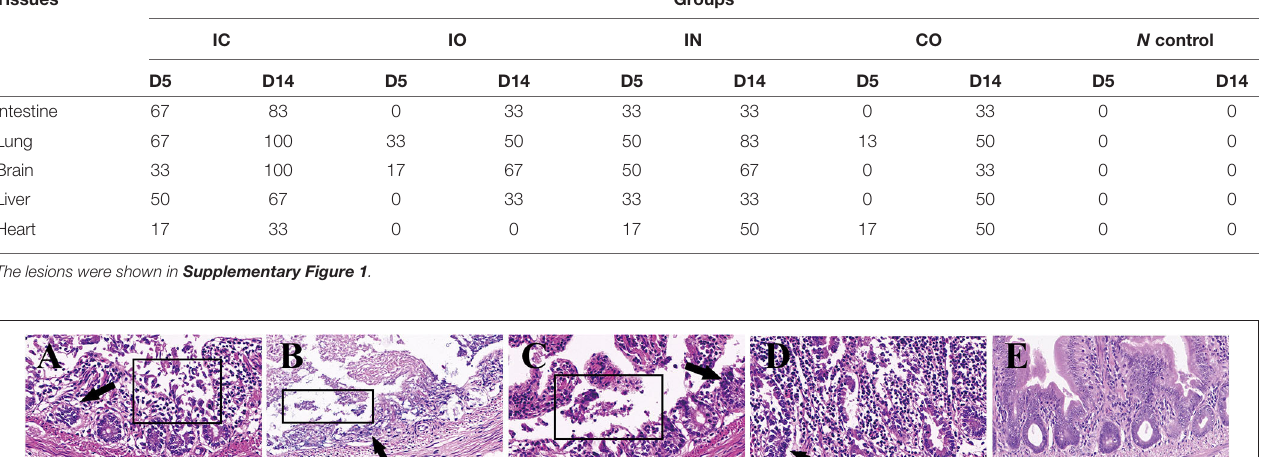
TABLE 1 | Percentage of PPMV-1 positive samples as determined by lesions examination. Tissues